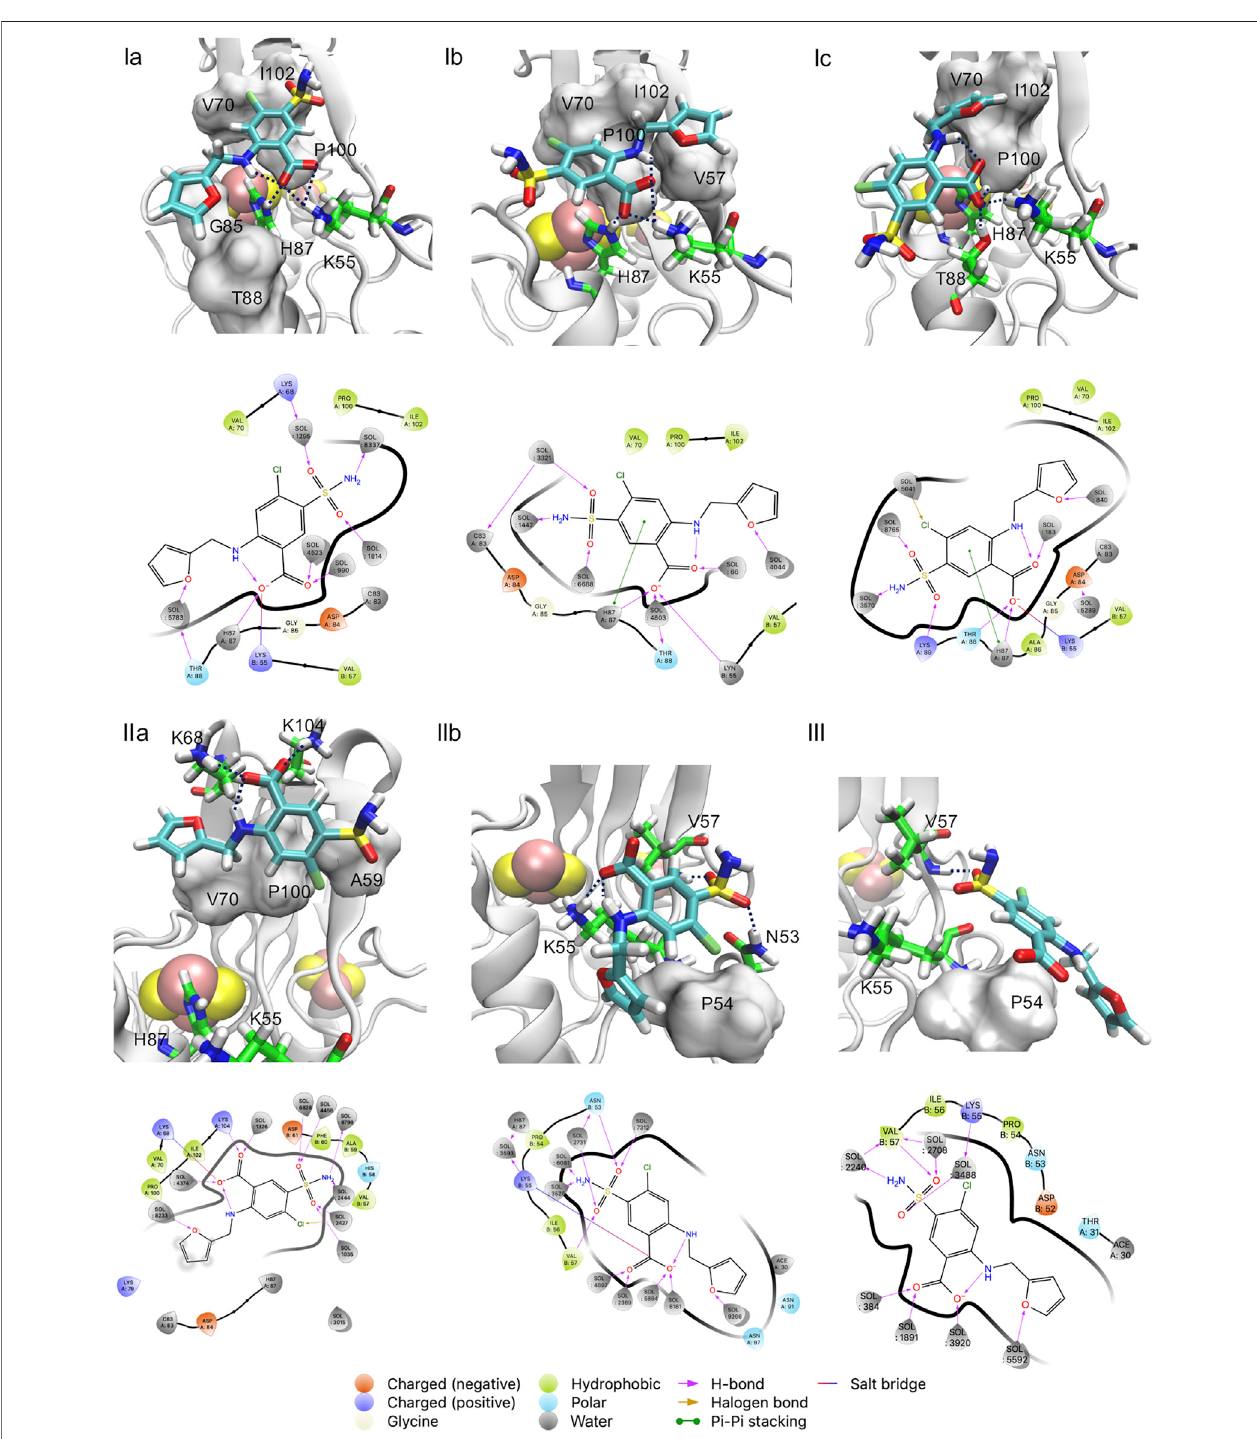
FIGURE 4 | (Ia – c, IIa,b, III ) poses of Figure 2 . Both the 3D structure and the ligand-protein interaction diagram are shown. H-bonds/salt bridges are drawn as dashed lines in the 3D structures.